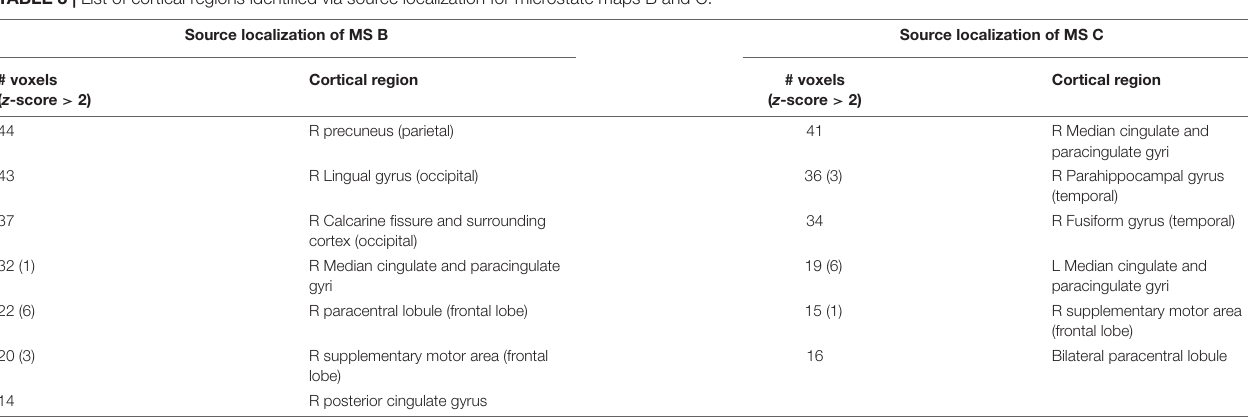
FIGURE 8 | Source localization of microstate maps B row (A) and C row (B) shown in Figure 3 . The first two columns show the source localization on the cortical surface. The last two columns show the sources ( z -score > 2) identified using the template fMRI head model. TABLE 3 | List of cortical regions identified via source localization for microstate maps B and